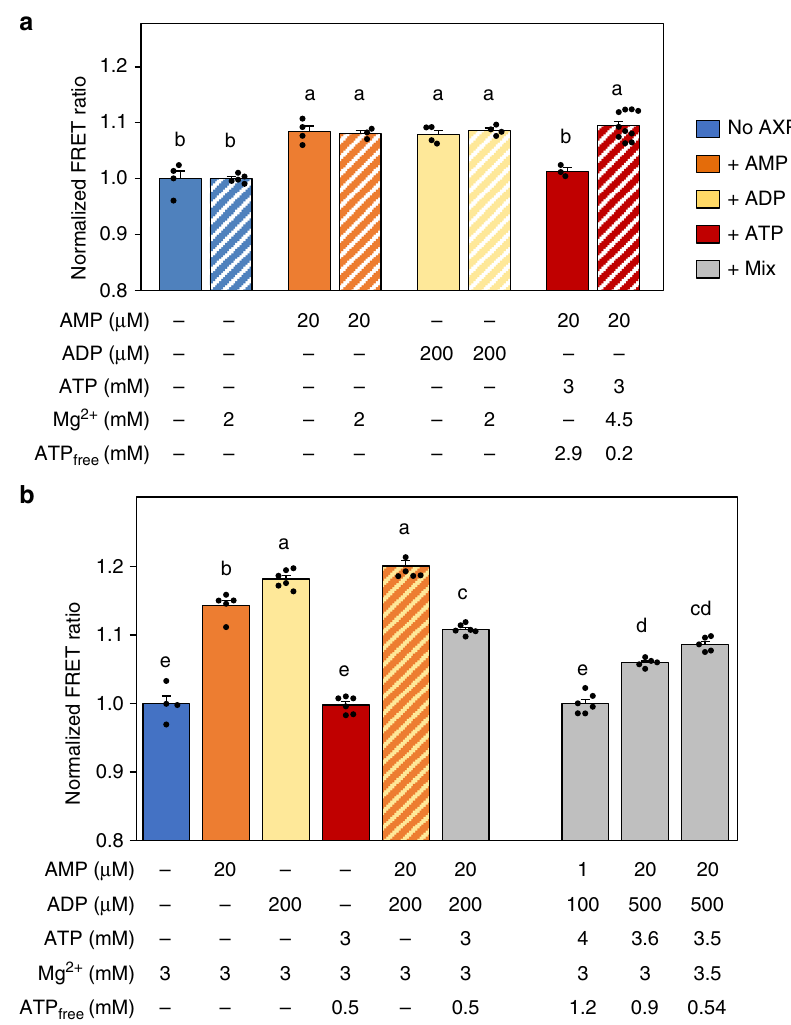
Fig. 4 Effects of adenylate mixtures on FRET changes. a Free ATP, not Mg 2 + -complexed ATP, competes with AMP. MgCl 2 does not affect AMPfret 1.0 baseline FRET (blue bars) and FRET induced by AMP (orange) or ADP (yellow), but prevents ATP-induced FRET inhibition (red). Plain and dashed bars, respectively, correspond to FRET signal measured in absence or in presence of Mg 2 + , respectively. b AMPfret 2.1 responses to individual adenylates and adenylate mixtures as indicated below the bars: no adenylates (blue), AMP (orange), ADP (yellow), ATP (red) AMP plus ADP (orange dashed yellow), mixtures of AMP, ADP, and ATP (gray). Bars to the right represent physiological mixtures with a shift to energy deprivation and emphasize the role of free ATP. The FRET signals are normalized to control (no adenylates). All data and error bars represent mean ± SEM ( n ≥ 3). After checking normality and equality of variance, statistical signi fi cance was analysed by one-way ANOVA followed by Bonferroni multiple comparison. Means sharing the same letter do not differ signi fi cantly ( p ≤